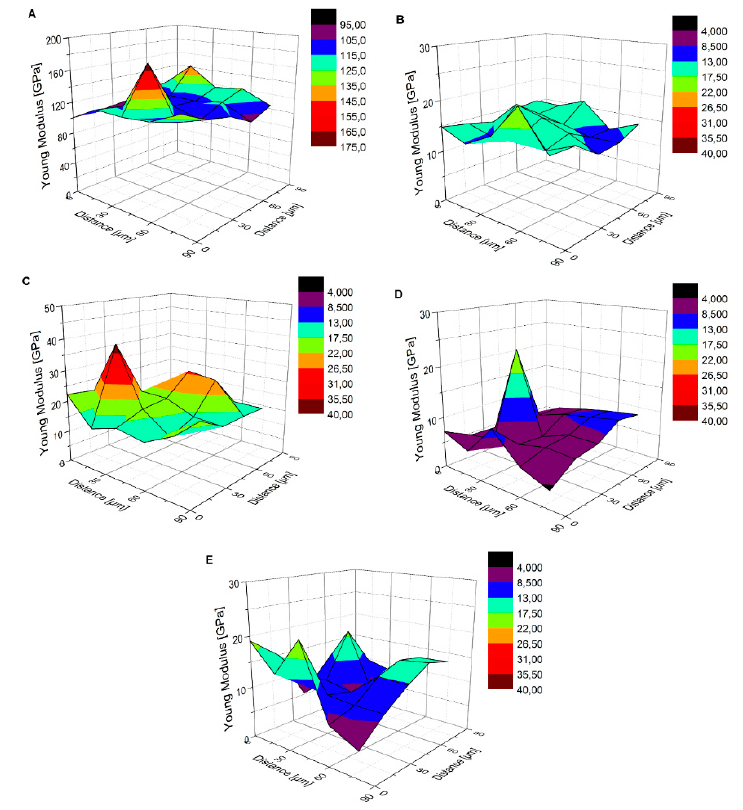
Figure 4. 3D Young’s modulus distribution for: ( A ) native material after grinding (MR), ( B ) native material after etching (MRe), ( C ) CNTs coating (0.27CNT), ( D ) CNTs deposited on HAp coating (H0.27CNT), ( E ) mixed coating consisting of CNTs, nanoHAp, nanoAg and nanoCu (m0.4CNT).